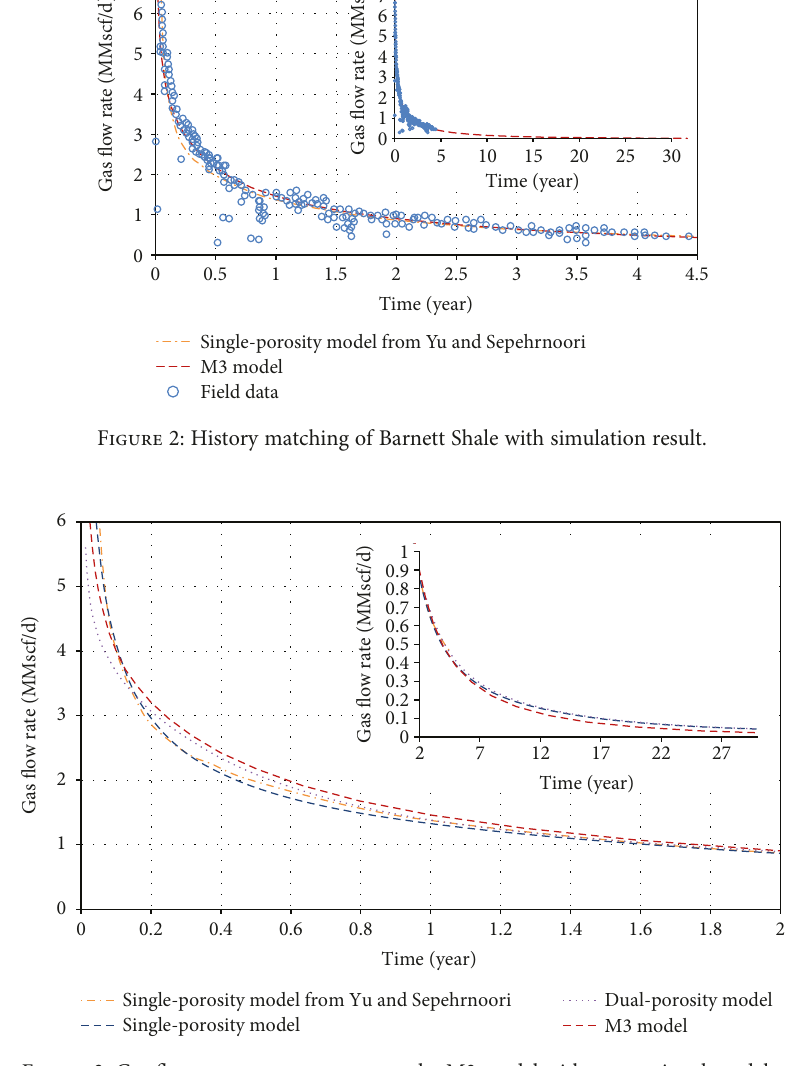
Figure 3: Gas fl ow rate curves to compare the M3 model with conventional